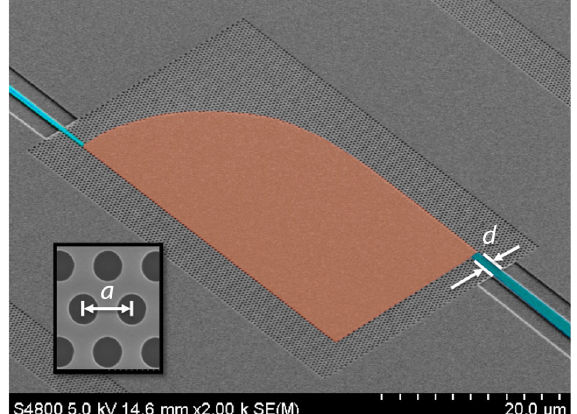
FIG. 1. SEM image of the quarter-stadium resonator. Inset: Enlarged image of the photonic crystal